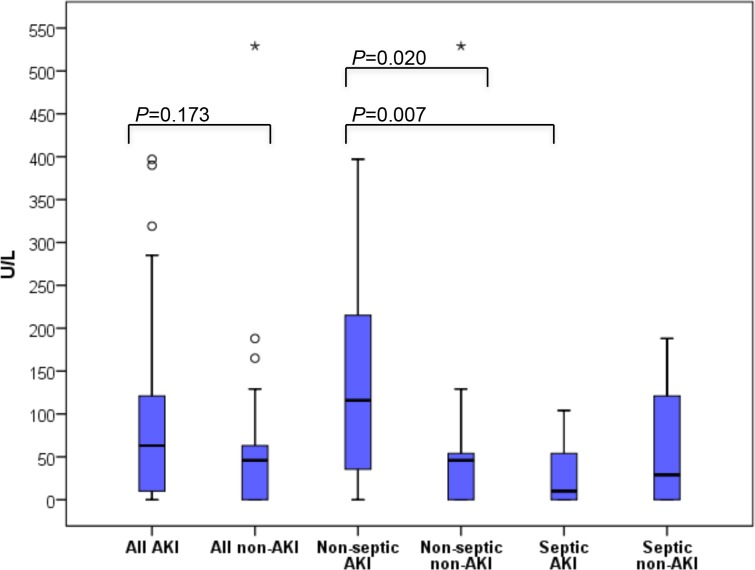
Box-plots presenting urine caspase-cleaved cytokeratin epitope M30 (U/l) levels measured 24 hours from ICU admission in the pilot study.AKI; acute kidney injury.